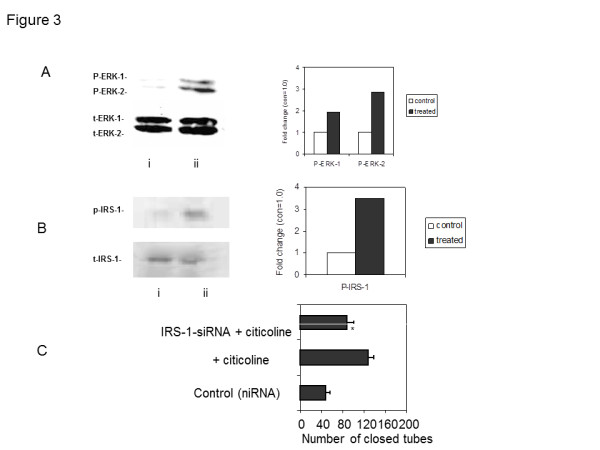
Citicoline increased expression of p-ERK1/2 and p-IRS-1 in citicoline-treated hCMEC/D3, and treatment with anti-sense siRNA directed against IRS-1 significantly inhibited tube-like structure formation. A and B) Representative Western blots showing the up-regulation of ERK1/2 and IRS-1 phosphorylation after 10 min stimulation of hCMEC/D3 in basal-serum-poor medium. (i) Control cells showed little p-ERK1/2/IRS-1 expression and (ii) after citicoline treatment (10 μM; 10 min) a notable increase was seen. Experiments were performed at least twice and a representative example is shown together with a bar chart showing the fold increase in expression. C) hCMEC/D3 treated with anti-sense siRNA directed against IRS-1, for 48 h prior to citicoline treatment (10 μM; 24 h), significantly reduced the ability of citicoline to induce tube-like structure formation in matrigel. Data shown are the result of a single representative experiment performed in triplicate wells. The bar graph illustrates the significant increase in the numbers of closed-loop areas in the presence of citicoline was reduced by approximately 50% in the presence of siRNA to IRS-1 (p = 0.018). Five areas from each well and 3 wells per treatment were analyzed.